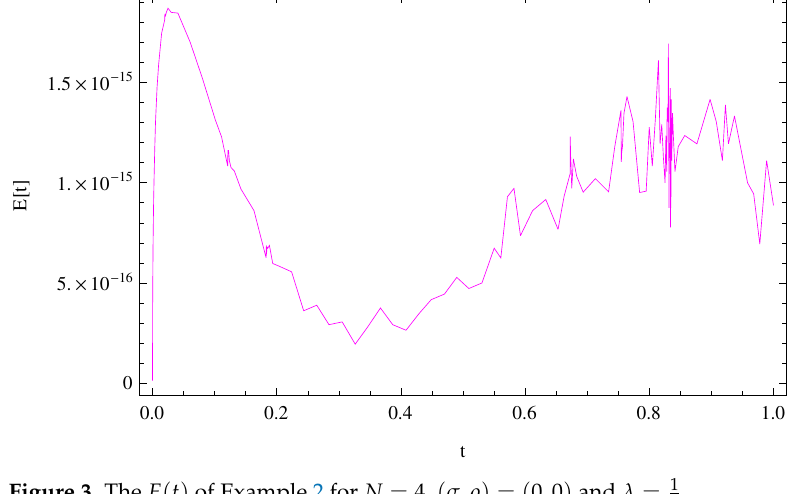
Figure 3. The E ( t ) of Example 2 for N = 4, ( σ , ρ ) = ( 0,0 ) and λ = 1